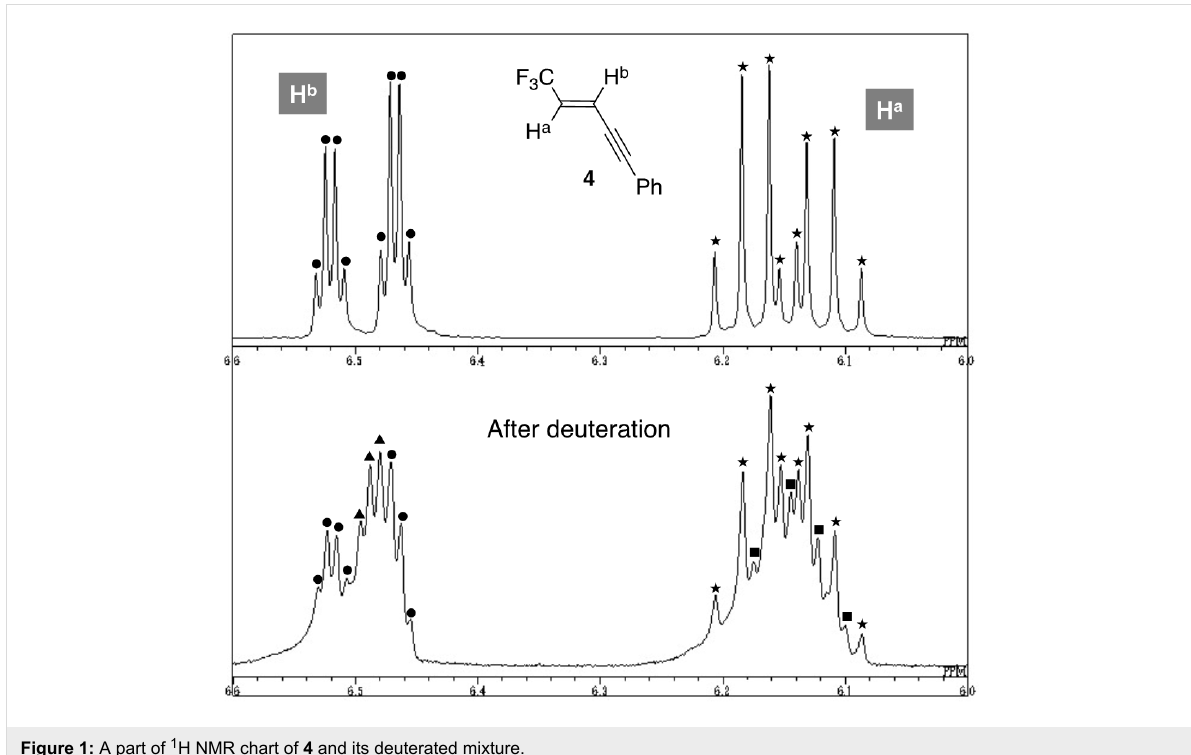
Figure 1: A part of 1 H NMR chart of 4 and its deuterated mixture.